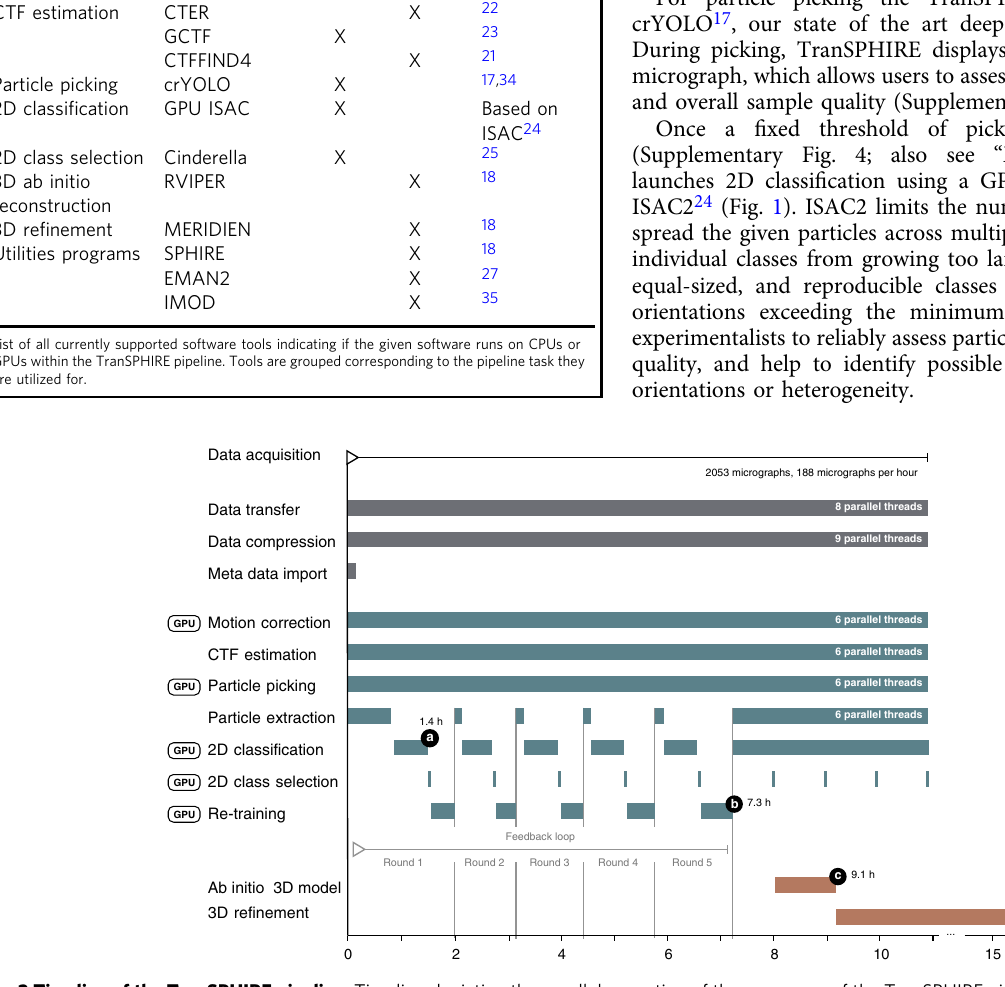
Fig. 2 Timeline of the TranSPHIRE pipeline. Timeline depicting the parallel execution of the processes of the TranSPHIRE pipeline. Timings are based on a Tc holotoxin data set consisting of 2053 micrographs, each containing 36 particles on average, collected at a speed of 188 micrographs per hour (K2 super- resolution, 40 frames). TranSPHIRE ran on-the- fl y up to the creation of an ab initio 3D reconstruction using default settings. Important milestones are denoted in black: a fi rst 2D class averages produced after 1.4 h; b end of the feedback loop after 7.3 h; c ab initio 3D reconstruction after 9.1 h; and d fi nal 3D reconstruction of the fi rst batch of particles after 15.5 h. Due to the internal scheduling of modern operating systems, and because not every TranSPHIRE thread is always working to capacity, the number of available CPUs (12/24 hyperthreading) and assigned TranSPHIRE threads (45) is not identical, and does not limit the speed of the computations. NATURE COMMUNICATIONS| (2020) 11:5716